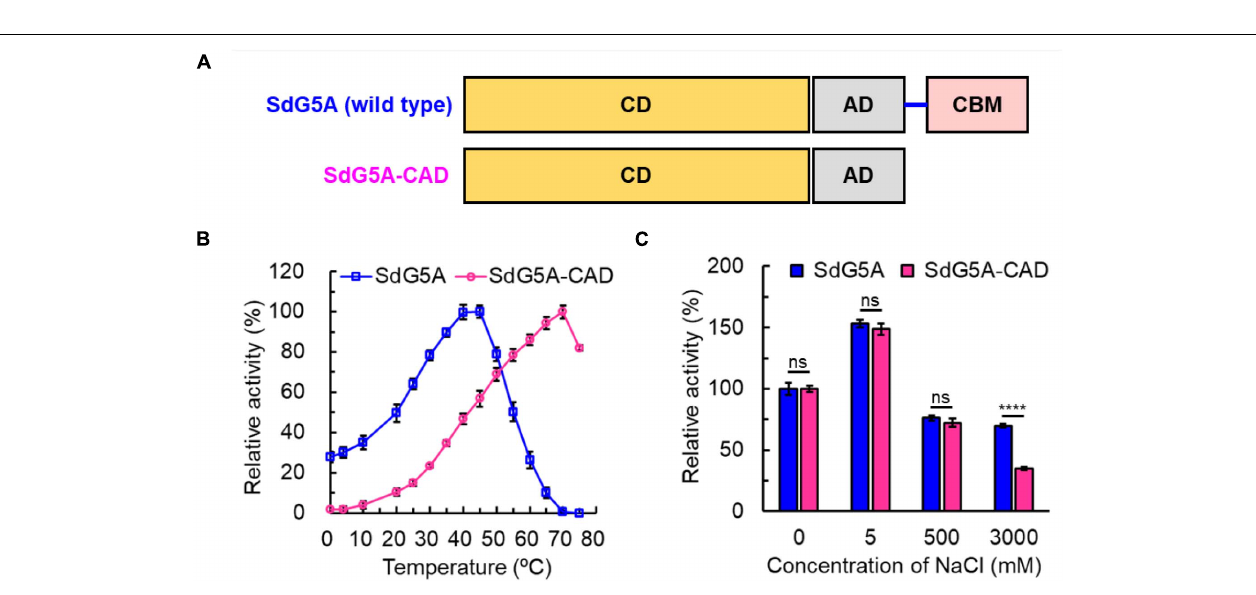
Frontiers in Microbiology |